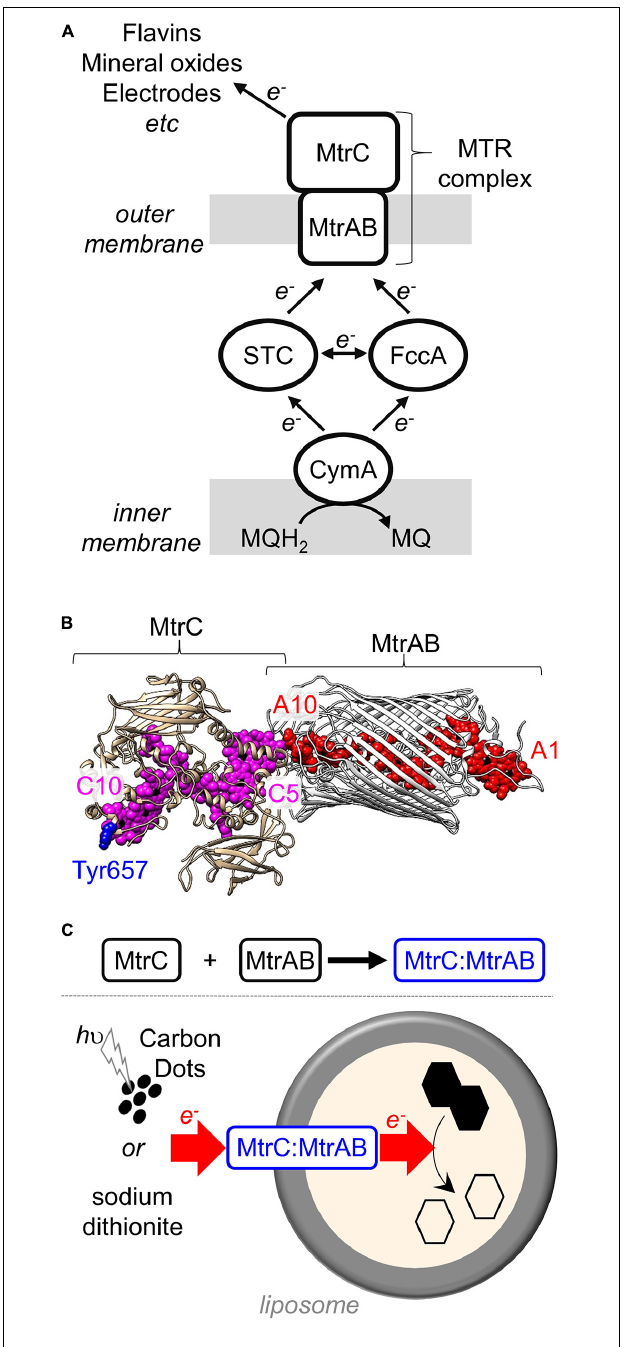
FIGURE 1 | The MTR complex of Shewanella . (A) Schematic of the electron transfer pathway in S. oneidensis MR-1 from menaquinol (MQH 2 ) to external terminal respiratory electron acceptors. (B) Model for the MTR complex of S. oneidensis MR-1 based on the crystal structure (Edwards et al., 2020) of S. baltica MTR complex. MtrAB (gray) showing the hemes (red). MtrC (tan) illustrating the location of the hemes (purple) and Tyr657 (blue). Hemes numbered according to their order of attachment to the primary sequence. Image rendered with Chimera. (C) Schematic of the in vitro association of MtrC and MtrAB (above) and trans-membrane electron transfer (below) through the resultant MtrC:MtrAB complex in proteoliposomes carrying the azo-dye cargo (black